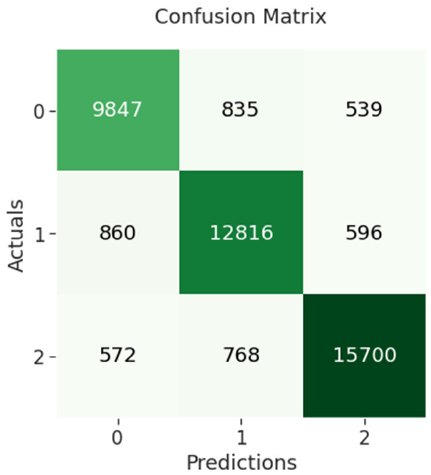
Figure 6. BiLSTM confusion matrix.